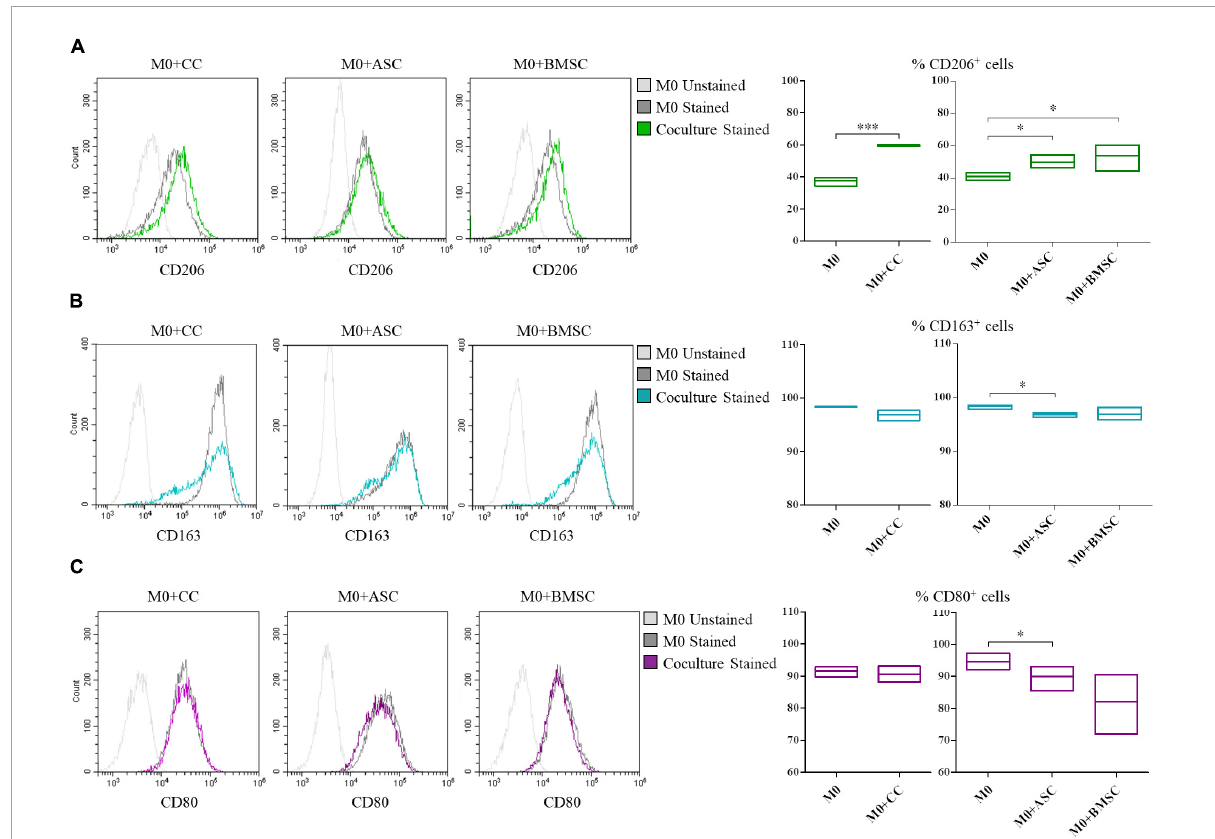
FIGURE4 Modulation of M0 macrophages polarization by cartilage cells (CCs), adipose tissue-derived (ASCs), and bone marrow-derived stem cells (BMSCs). For CD206 + (A) , CD163 + (B) , and CD80 + (C) cells representative plots overlay show M0 co-cultured with the different cell types. Floating bars represent mean to max percentages and mean values of cells positive for the different analyzed markers in M0 and co-cultured M0 with CCs, ASCs, and BMSCs. N = 3; ∗ p < 0.05, ∗∗∗ p <